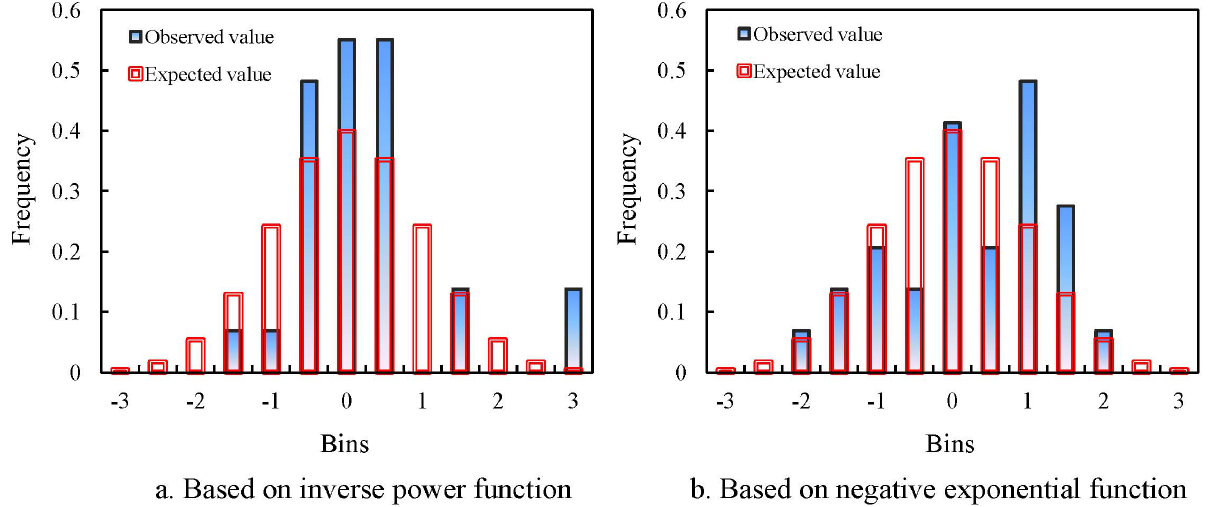
Figure 5. The normal histograms of error distributions based on different spatial weight functions for China’s cities (2000). (Note: These graphs are created using standardized error series. The filled bars represent the actual distributions based on observed values, while the unfilled bars with double frames represent the normal distributions based on the expected values, which form bell-shaped histograms.) [a. Based on inverse power function; b. Based on negative exponential function].